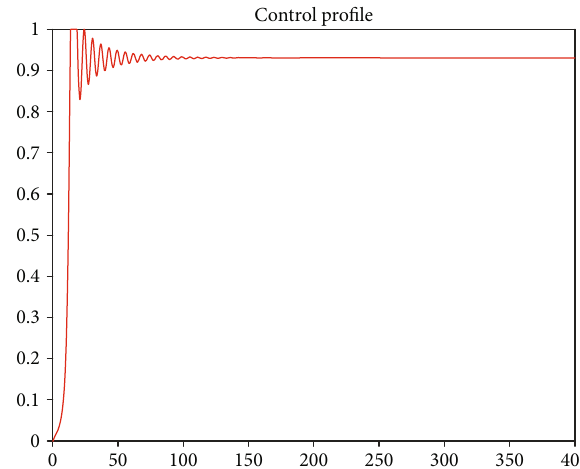
Figure 7: Control pro fi le of delayed HIV/HBV model. Parameter values are as shown in Table 1. Horizontal axes represent time in